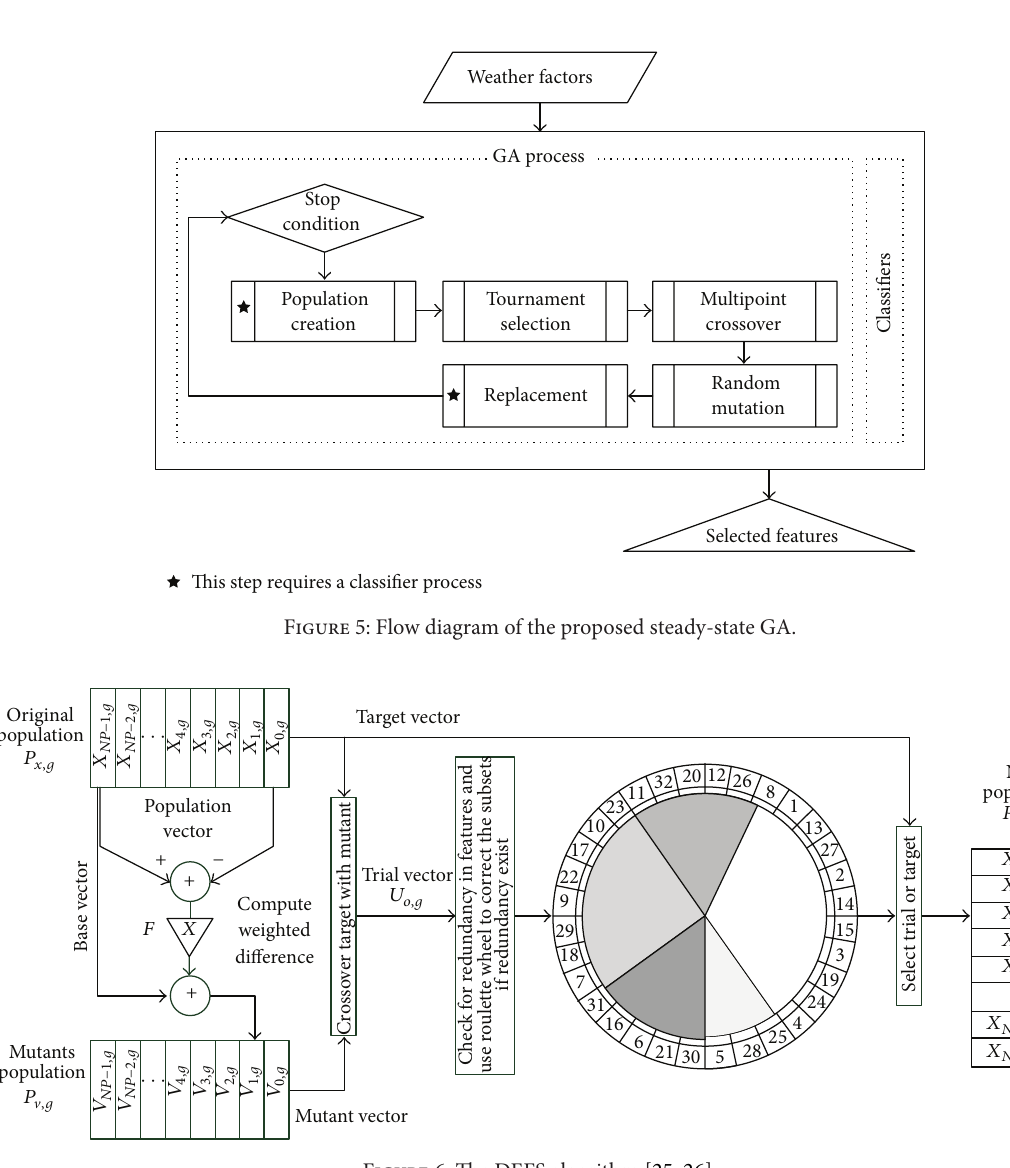
Figure 6: The DEFS algorithm [25,